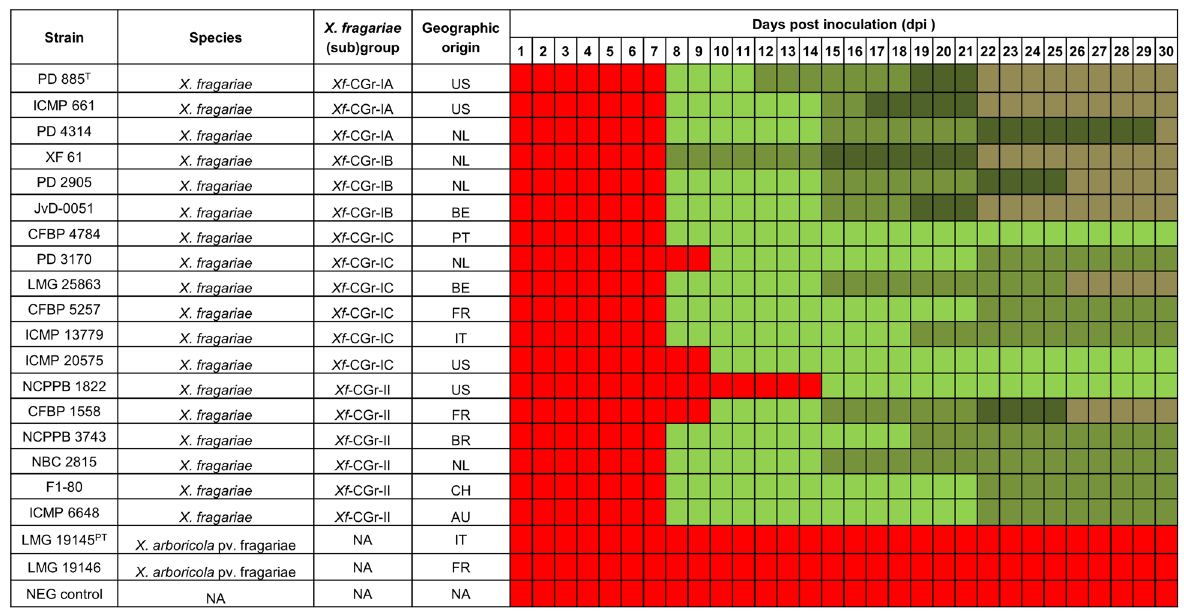
Fig. 6 Outcome of the inoculation test of strawberry plant Fragaria × ananassa variety Elsanta. The inoculation tests were carried out with 18 Xanthomonas fragariae strains belonging to all X. fragariae (sub)groups. Additionally, inoculations with two X. arboricola pv. fragariae strains and a buffer-only control were carried out. The evolution of the symptoms was color-coded (red (0) = no symptoms; light green (1) = low number of spots, visible through the leaf with a light; middle dark green (2) = extensive spots visible on both sides of the leaf; dark green (3) = extensive spots coloring into yellow, tending to necrosis; brown (4) = necrotic regions on leaves)